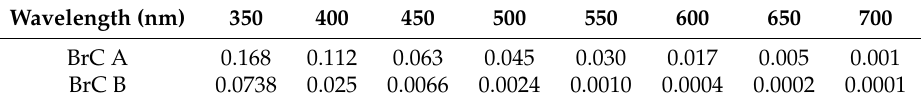
Table 3. Imaginary parts of the refractive index of BrC.